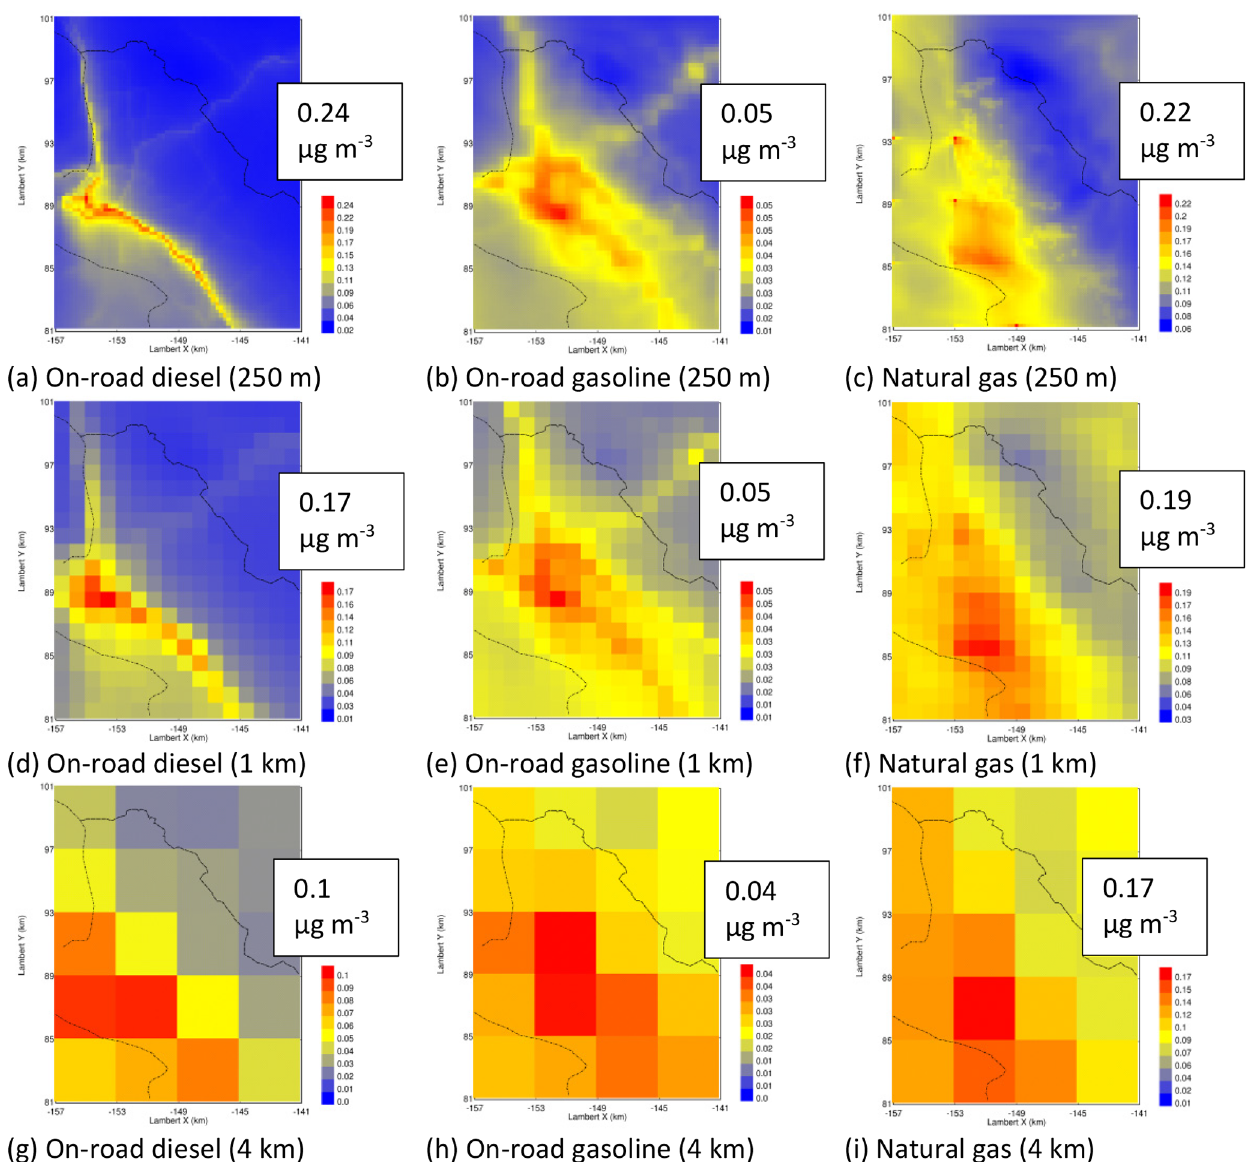
Figure 4. PM 0 . 1 mass concentration associated with on-road diesel, on-road gasoline, and natural gas combustion at 250m, 1km, and 4km resolution over Oakland,